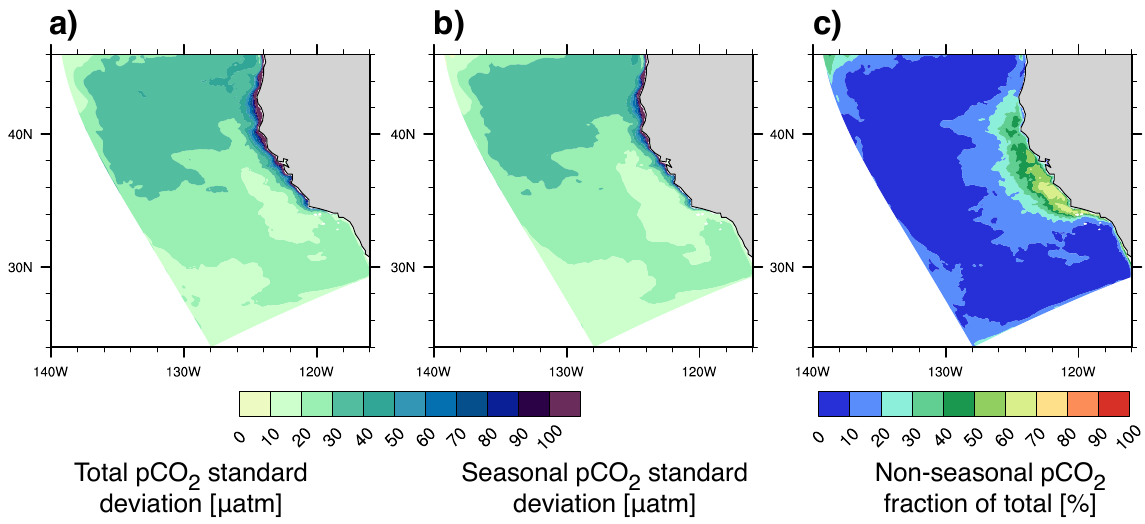
Fig. 8. Total p CO 2 standard deviation (a) computed from 2–day output spanning seven consecutive model years, and seasonal p CO 2 standard deviation (b) derived from a fitted mean over the same seven years. Panel (c) shows the fraction of the total p CO 2 variance (square of the standard deviation) attributable to nonseasonal variability, i.e. the difference between total and seasonal p CO 2 variance divided by the total variance (shown in